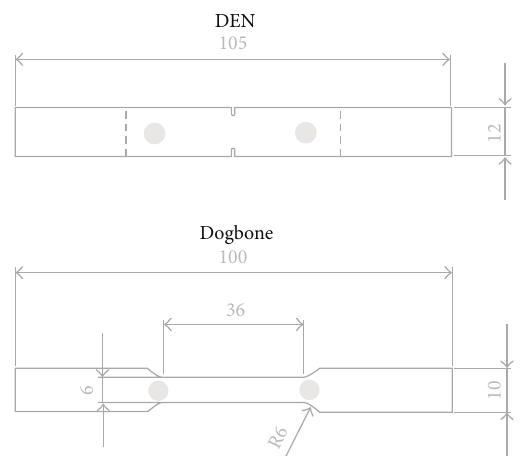
Figure 1: Double-edge-notch and dogbone specimen configura- tions with marked AE monitoring locations (grey circles).